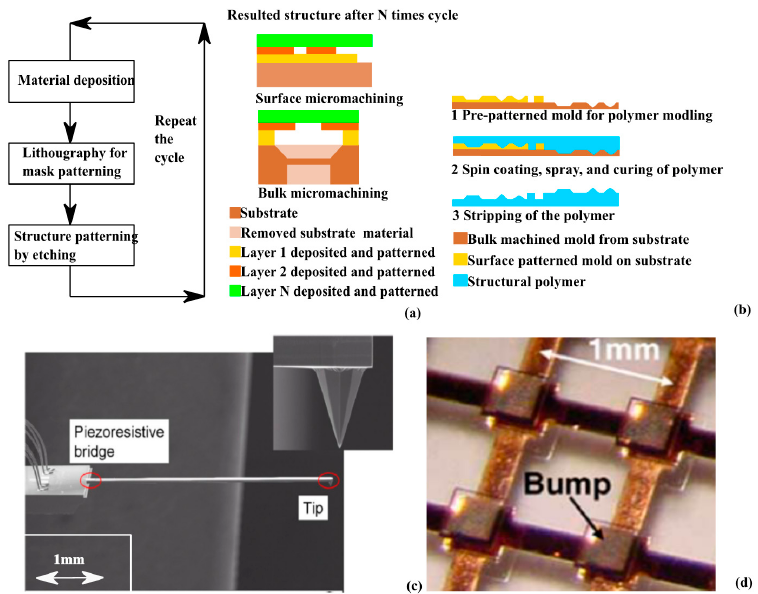
Table 2. Comparisons of tactile sensor material